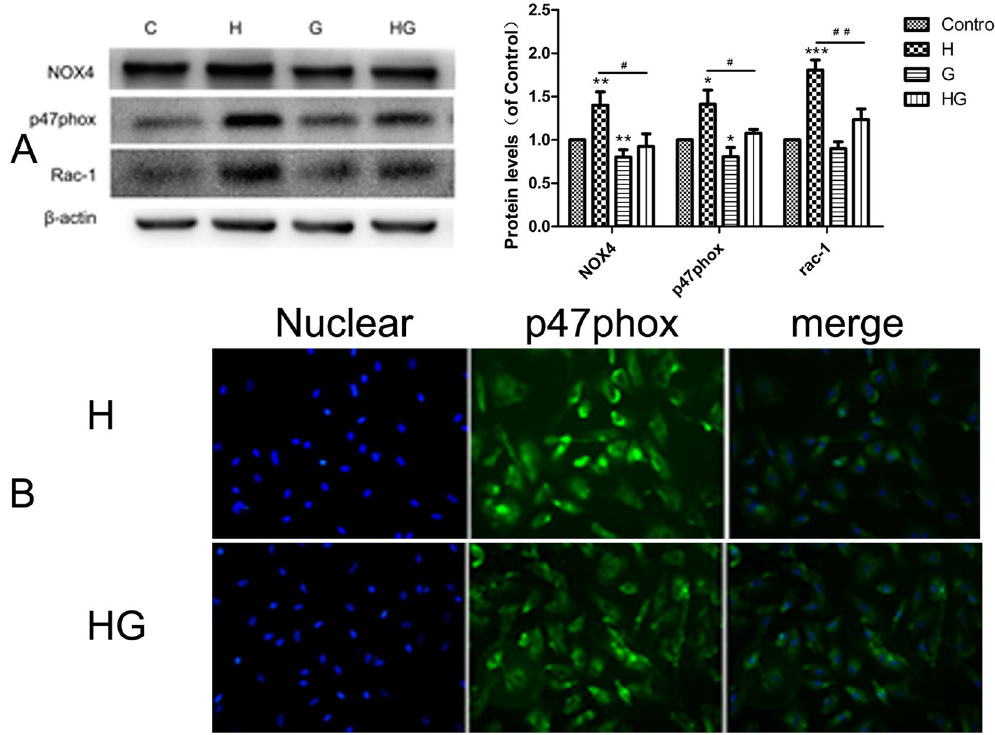
Figure 6. GLP-1 pretreatment attenuated NOX4, p47phox and Rac-1 expression and p47phox translocation. GLP-1 decreased NOX4, p47phox and Rac-1 expression ( A ). GLP-1 decreased p47phox translocation induced by high glucose ( B ). Data are shown as the mean ± SEM, n = 3 independent experiments. * P < 0.05 vs control. # P < 0.05 vs high glucose, ** P < 0.01 vs control, ## P < 0.01 vs high glucose, *** P < 0.001 vs